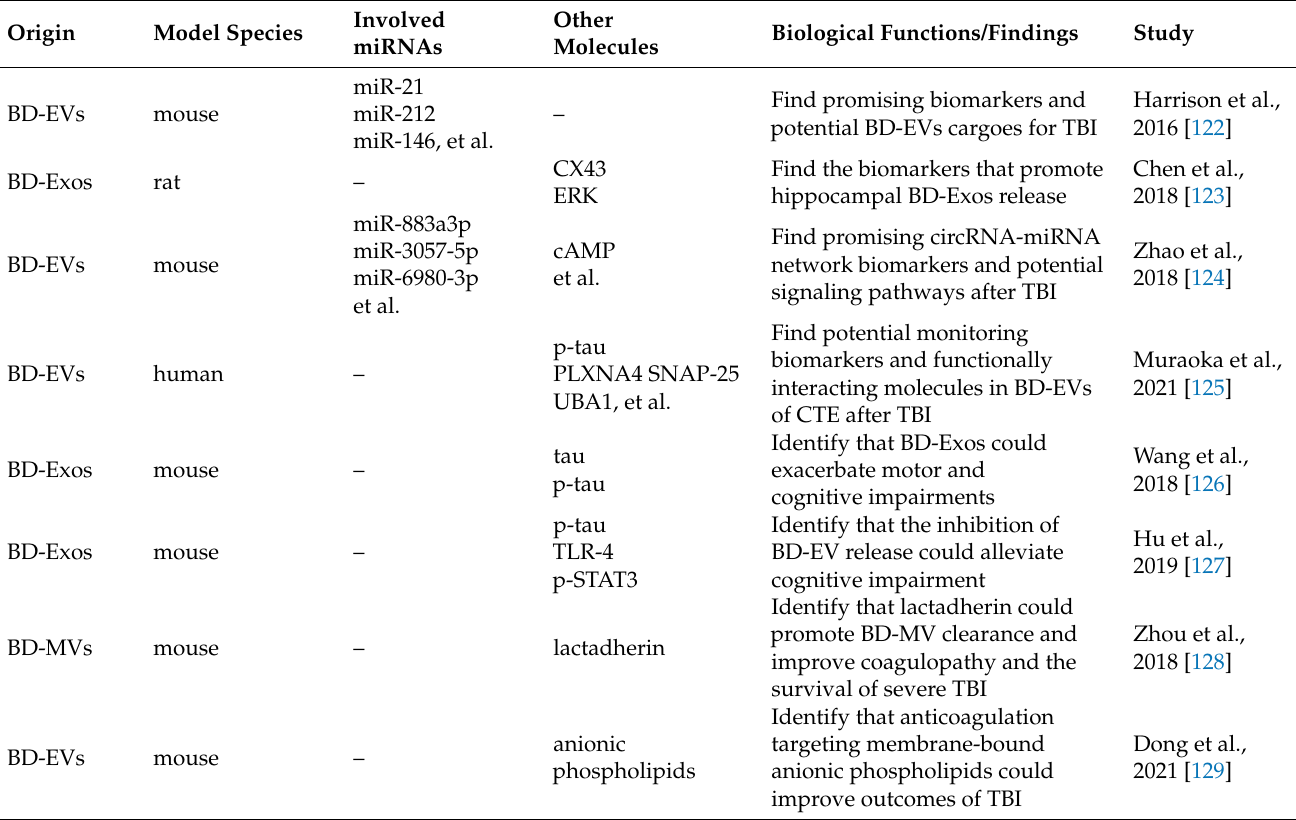
Table 8. Brain-derived Exos/EVs and BD-Exos/EVs-miRNAs studies in